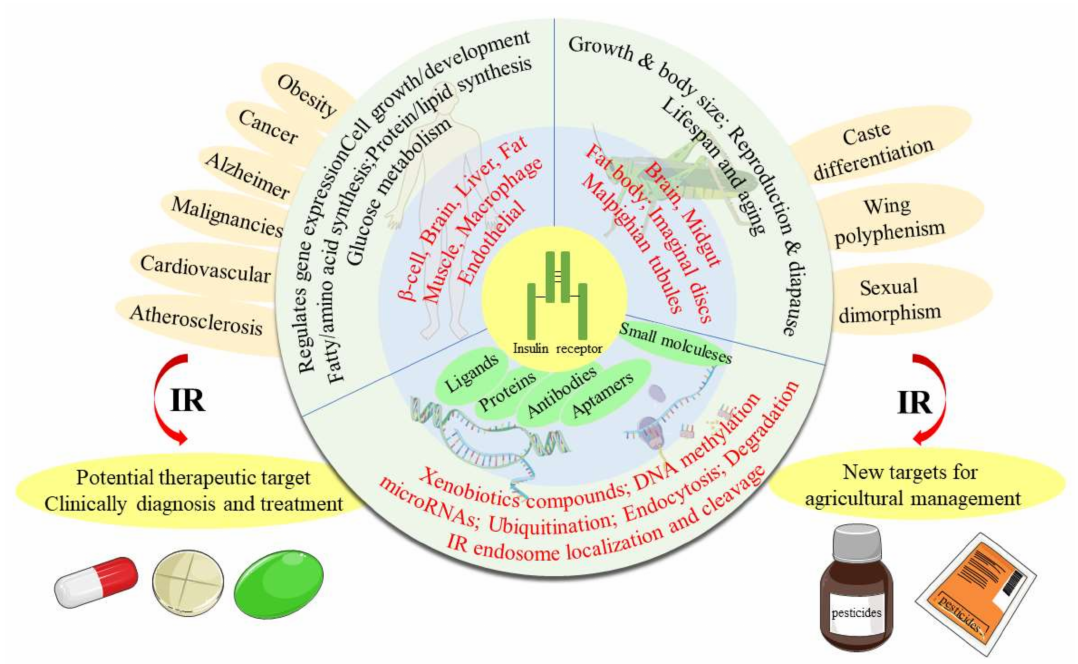
Figure 10. Summary of the contents and the